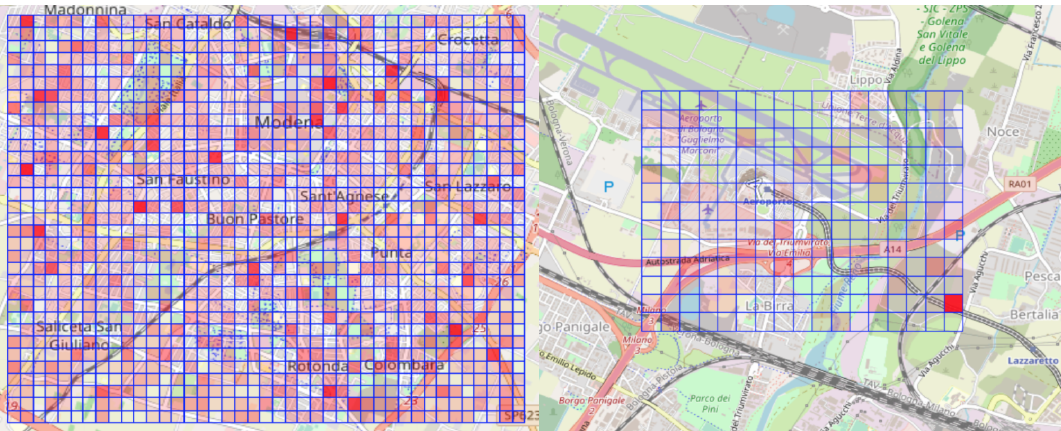
Figure 1. Grid of aggregated CDR mobile data. The grid on the left is 5 km 2 and covers a medium size city center. The grid on the right is smaller 2.5 km 2 and covers an